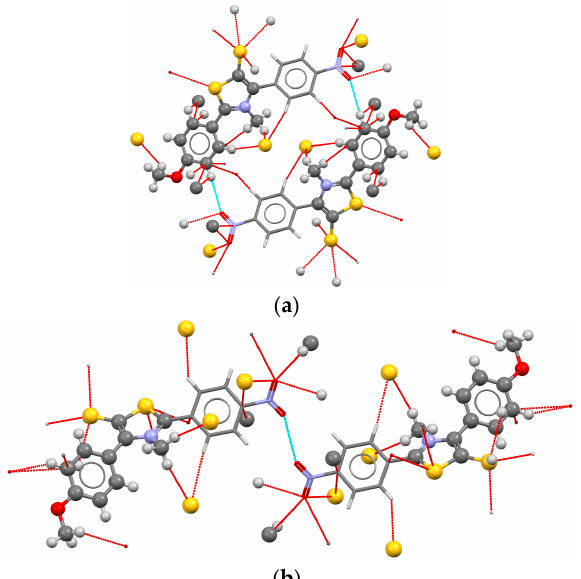
Figure 3. Intermolecular interactions (red or blue dot lines) in crystals of 1,3-thiazolium-5-thiolate derivatives ( a ) MAGTEV, twist angle of the NO 2 group equal to 6.22 deg; and ( b ) MAGTIZ, twist angle = 41.06 deg. The p -nitrophenyl part is presented by sticks, red lines show intermolecular interactions while not showing neighboring molecules, whereas bolls (very small and larger) indicate atoms of the molecule.